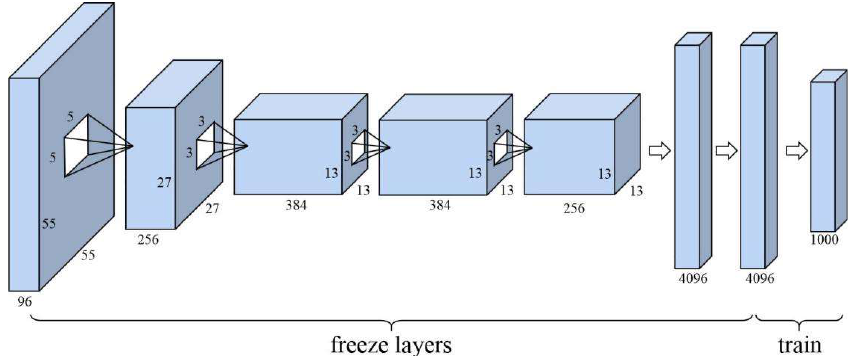
Figure 1. Transfer learning principles diagram.